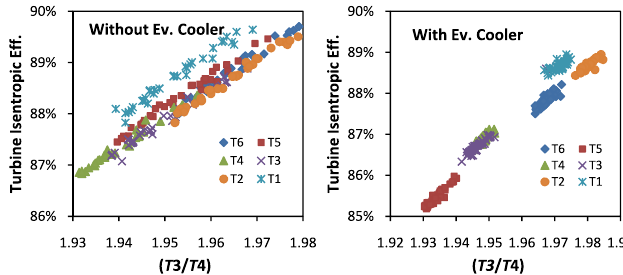
Fig. 7. Turbines isentropic ef fi ciencies against temperature ratio.